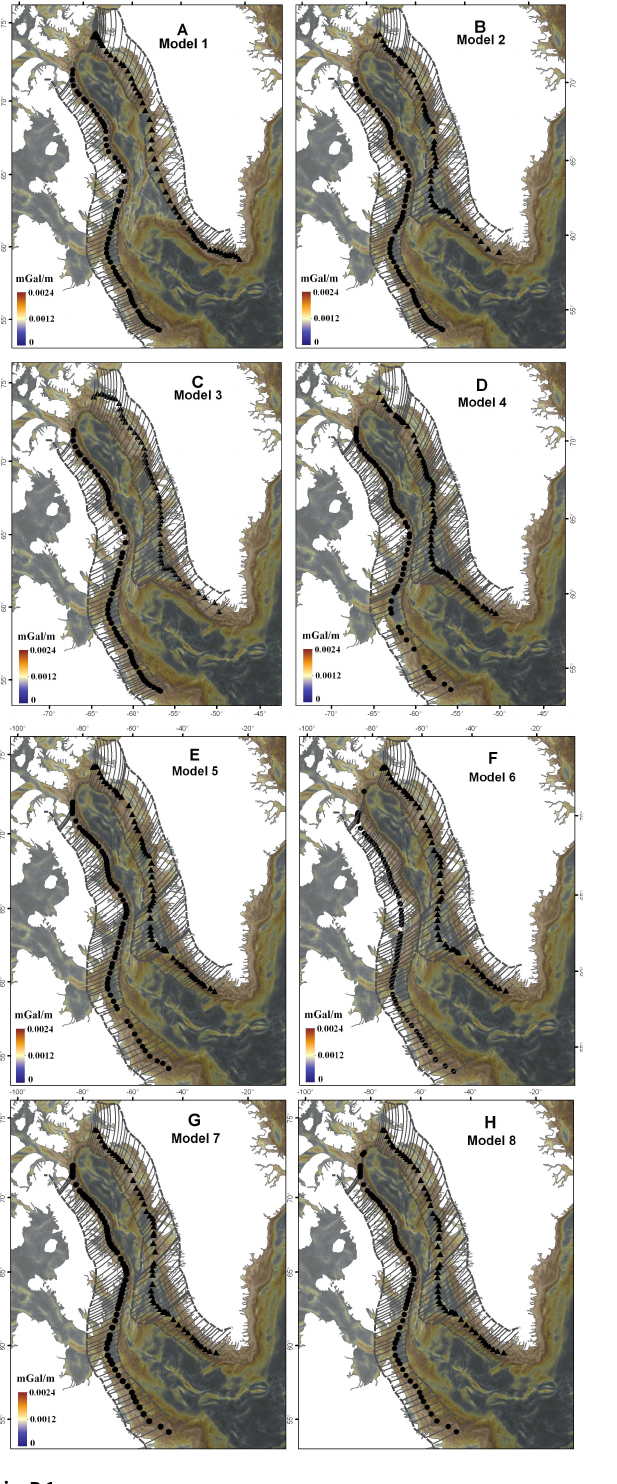
Fig. B1. Restoration of present-day COBs in to their pre-rift positions in conjugate margins. The restoration has been applied for the all eight models in this study. UCCL lines and present-day COBs have been shown in grey dashed lines, while the restored COBs are shown as black circles for the North America and black triangles for the Greenland margin. Thin solid lines are small circle paths showing the direction of mo- tion during the restoration process. The background map is the total horizontal gradient of Bouguer gravity map corrected from EGM08 gravity model.